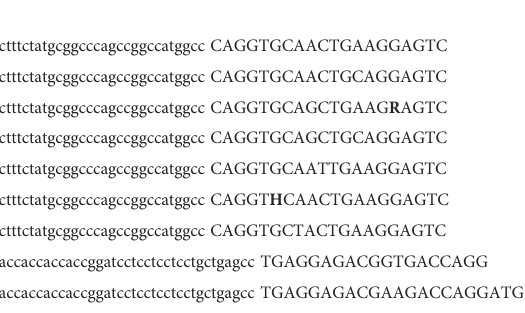
TABLE 1 EquPD v2020 primer set for equine V-genes ampli fi cation used for PD libraries